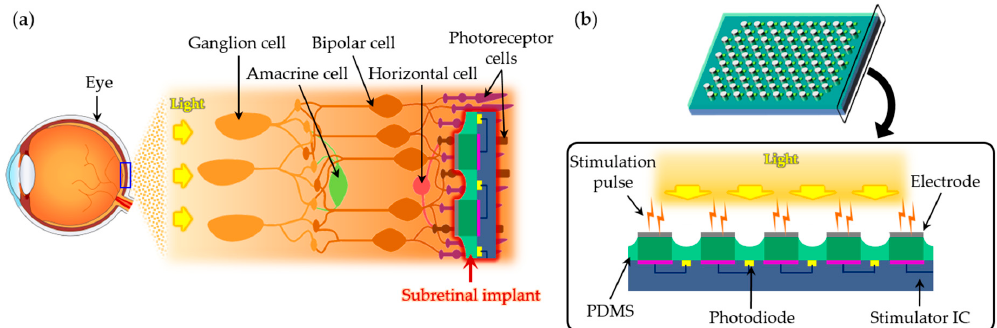
Figure 1. Schematic illustrations of microelectrodes for subretinal stimulation. ( a ) The subretinal implant is placed between the outer nuclear layer (ONL) and the retinal pigment epithelium (RPE) to stimulate non-spiking neurons. ( b ) Stimulation pulses are generated when photodiodes in the implant convert light into electrical signals.